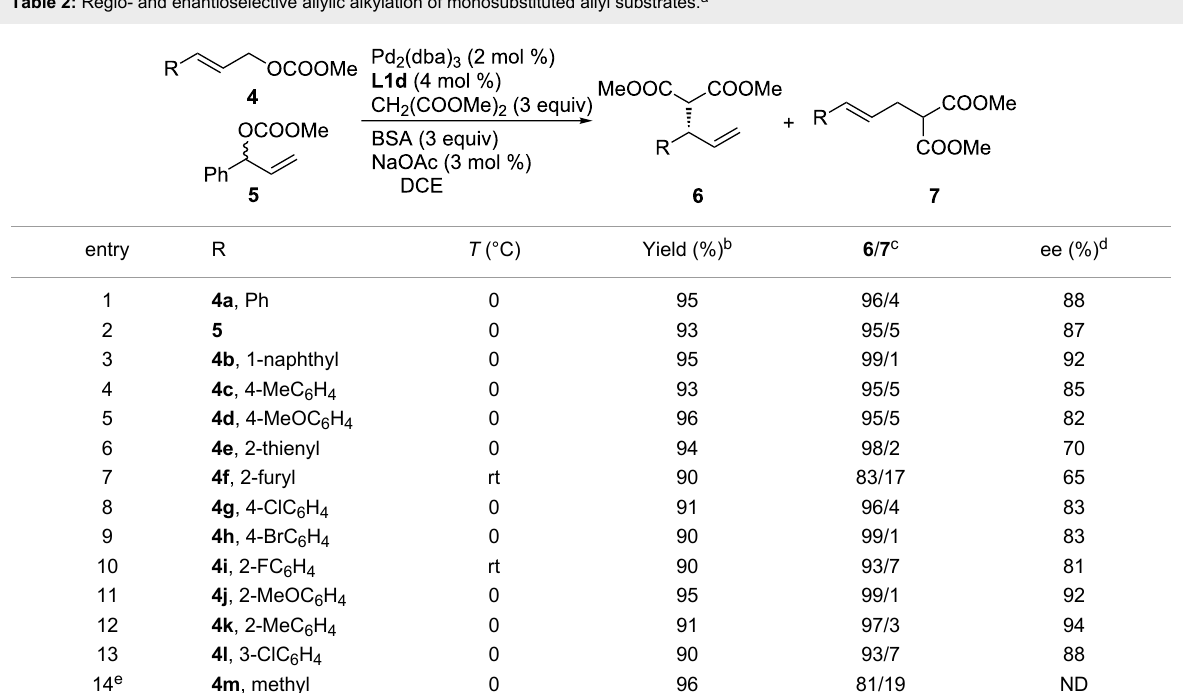
Table 2: Regio- and enantioselective allylic alkylation of monosubstituted allyl substrates.